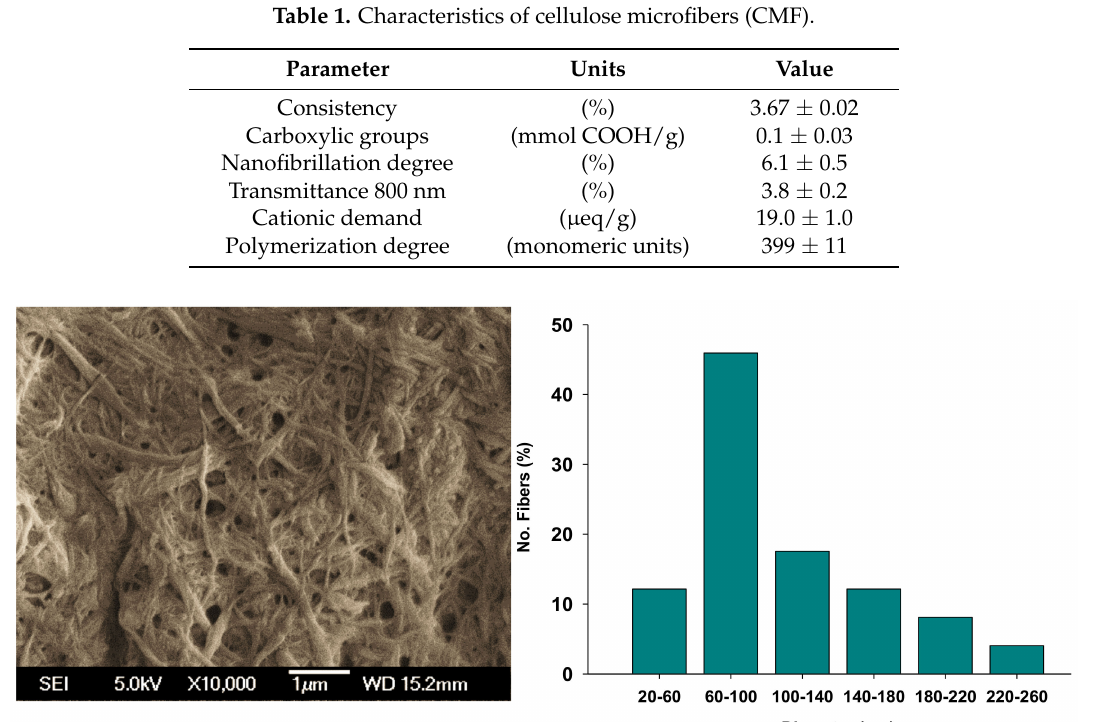
Figure 1. CMF characterization. ( a ) SEM image and ( b ) CMF diameter